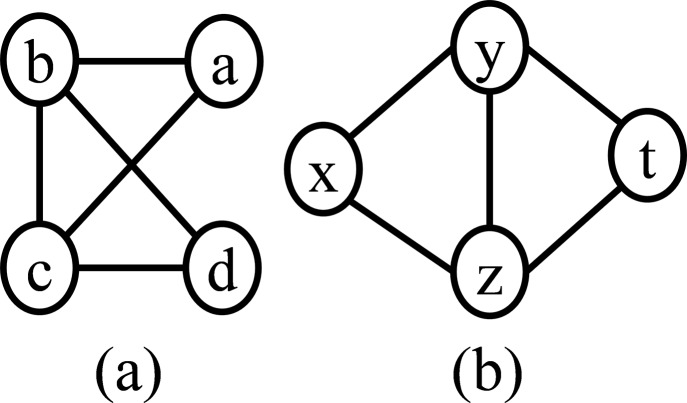
Graph (A) and graph (B) is isomorphic with each other, where the bijective function \documentclass[12pt]{minimal}
\usepackage{amsmath}
\usepackage{wasysym}
\usepackage{amsfonts}
\usepackage{amssymb}
\usepackage{amsbsy}
\usepackage{upgreek}
\usepackage{mathrsfs}
\setlength{\oddsidemargin}{-69pt}
\begin{document}
}{}$f:V_{S_1} \to V_{S_2}$\end{document}f:VS1→VS2 defined as a → x, b → y, c → z, and d → t.